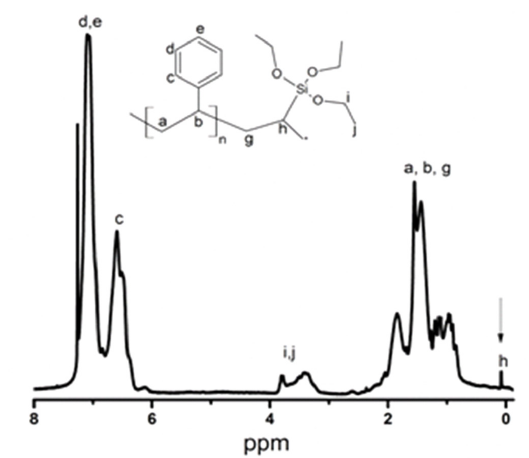
Fig 1. 1 H-NMR spectrum of macrosilane S1. The presence of VTES units is corroborated by the signal at 0.2 ppm which is assigned to the H atom in C bounded to the silicon